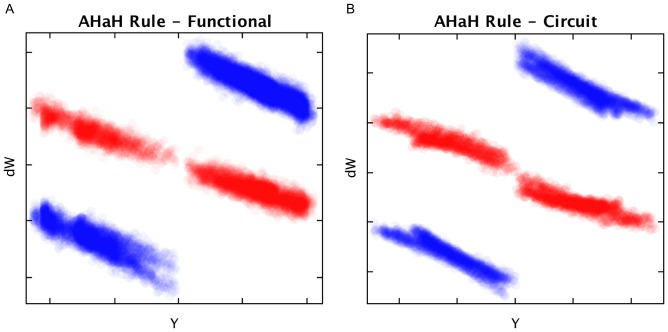
The AHaH rule reconstructed from simulations.Each data point represents the change in a synaptic weight as a function of AHaH node activation, y. Blue data points correspond to input synapses and red data points to bias inputs. There is good congruence between the A) functional and B) circuit implementations of the AHaH rule.